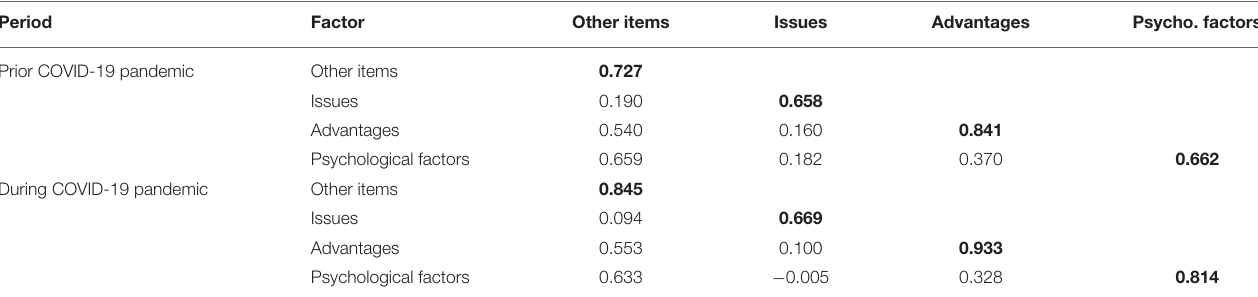
TABLE 9 | CFA model discriminant validity. Period